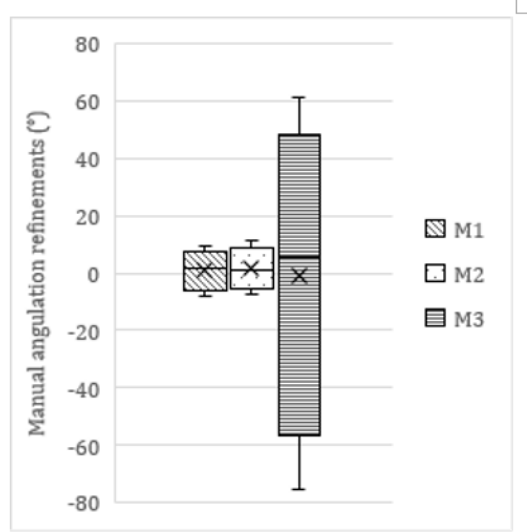
Figure 5. The mean manual refinements on the network measurements displayed per molar. Manual edits to the first (M1) and second (M2) molar were small and limited. Manual edits to the third molar (M3) varied widely. These differences were statistically significant ( p = 0 .0421).